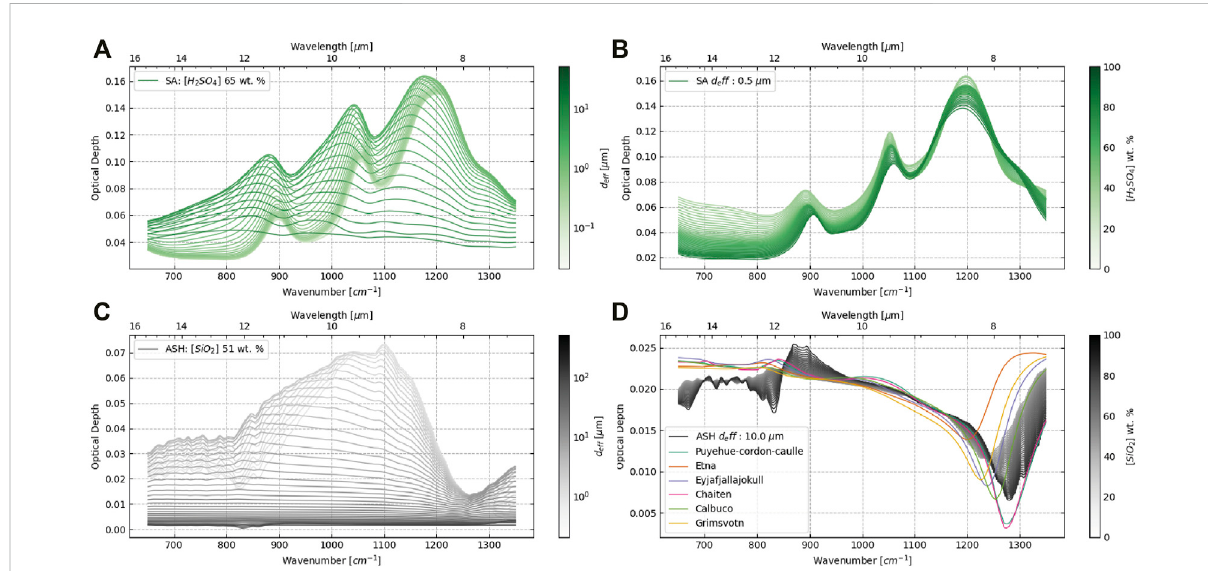
FIGURE 5 Optical depth reference spectra for both particle typesconsidered inthe retrieval: sulphate aerosols (SA) ( (A,B) — green) and ash (( C , D — grey) (A and C) Optical depth cross sections as a function of particle size. All reference spectra are calculated for the same mass volume concentration of 1x10 − 3 g m − 3 ,and onlytheparticlesize distribution(PSD) varies. PSDsare log-normalwith ameaneffective diameter varyingaccordingto thecolour scale (0.1 – 10 μ m for SA and 0.1 – 200 μ m for ash) and a sigma value of 1.5 (B and D) Optical depth spectra as a function of chemical composition.Theeffectiveparticlediameter iskeptconstant(0.5 μ mforSA,10 μ m forash),andonlythecomposition varies. SAcompositionsrange from38to81 wt%H 2 SO 4 ,andspectra arecalculated usingrefractiveindicesfrom(LundMyhreetal.,2003).Ashbulk compositions rangefrom 45to 80 wt% SiO 2 , and spectra are calculated using the parameterization algorithm for complex refractive indices found in (Prata et al., 2019). The mass volumeconcentrationisagain fi xedat1x10 − 3 g m − 3 .Alsoshownaresomeexamplespectracalculatedfornaturalsamplesfromrecenteruptionswith refractive indices found in (Deguine et al., 2020) for the same particle